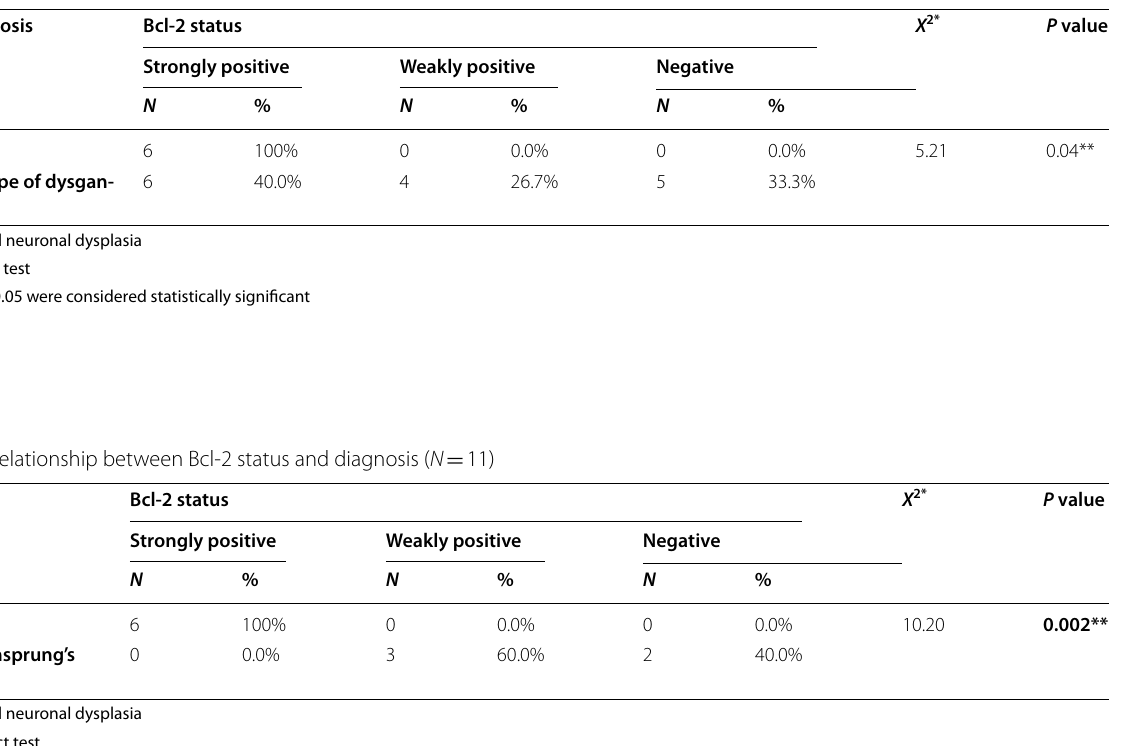
Table 3 Relationship between Bcl-2 status and a final diagnosis of IND ( N